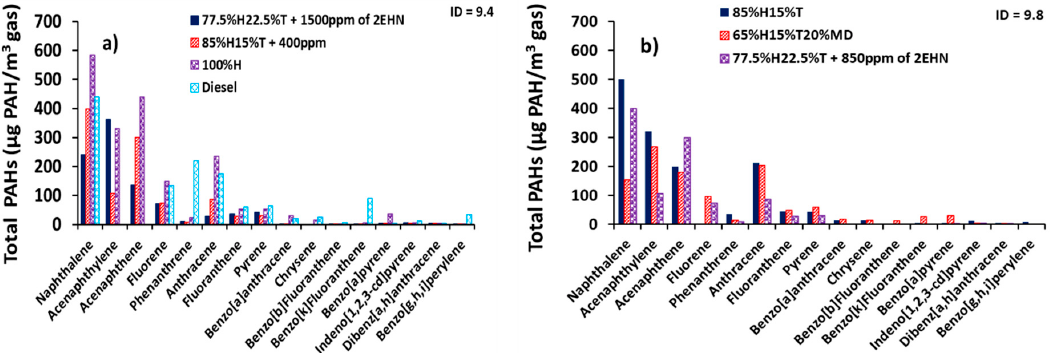
Figure 8. Distributions of total exhaust PAHs (GP + PP) ( µ g of PAH / m 3 of gas) at constant ignition delay ( a ) ignition delay (ID) = 9.4 CAD and ( b ) ID = 9.8 CAD.